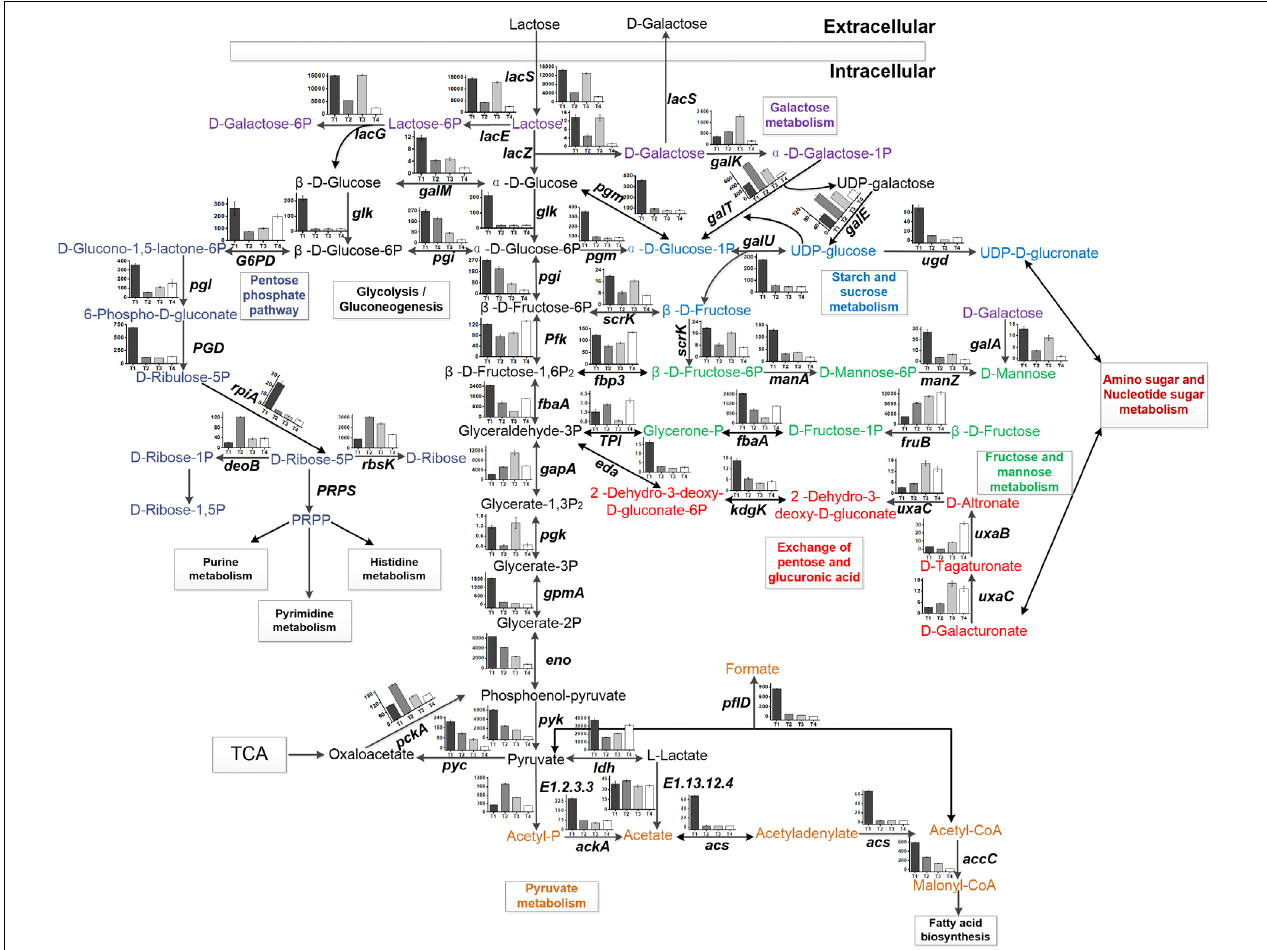
FIGURE 4 | Central carbon metabolism of ST-MZ-2. The histogram shows the FPKM of the genes involved in carbohydrate metabolism at four sampling points during the growth of ST-MZ-2.